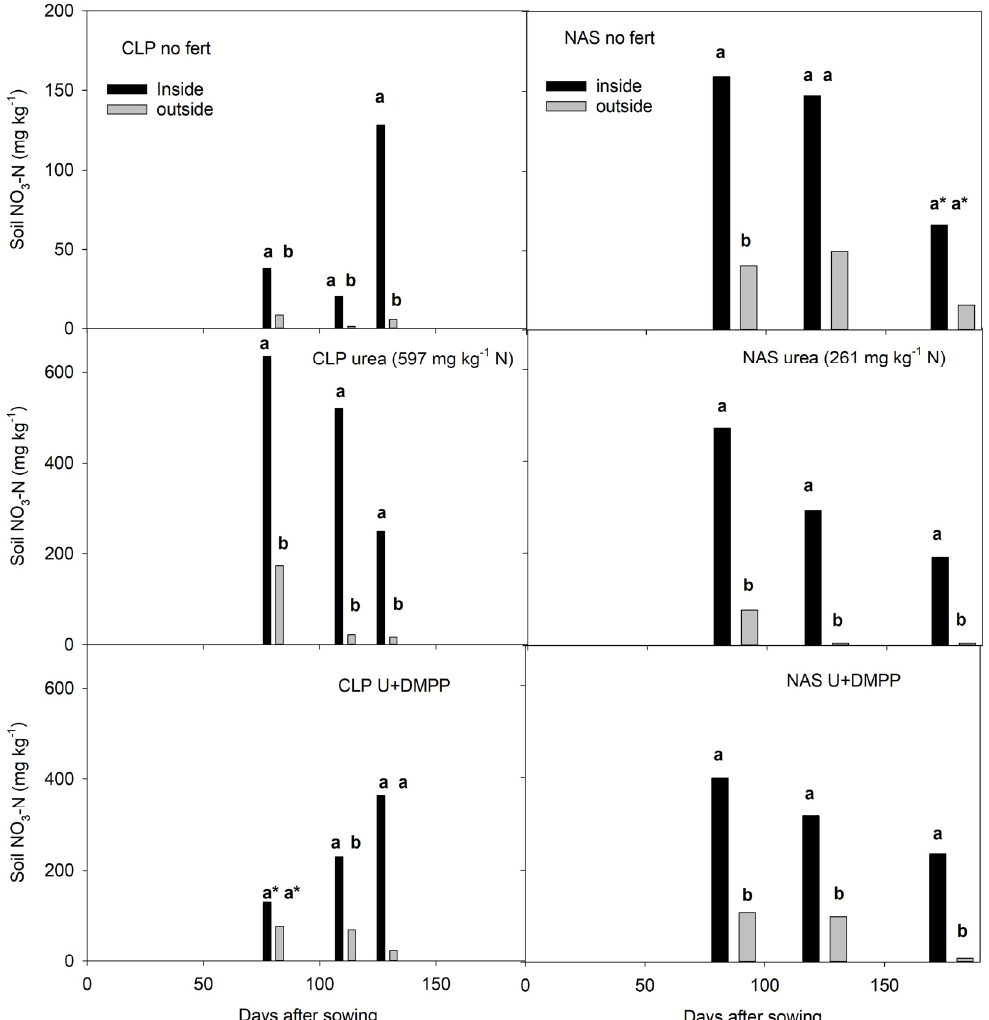
Figure 3. Soil 2M KCl-extractable NO 3 -N inside and outside root exclusion cylinders adjacent to the plant row of unfertilized, urea, and DMPP-coated urea soil at CLP and NAS sampled at key growth stages over the 2016/17 season. Results for soil NH 4 -N are not included as most were below the lowest level of reporting. Numbers in brackets indicate the N application rate per kg of soil. Bars within each sampling time (days after sowing) with the same letters are not significantly different ( p > 0.05). Asterisks indicates results for the pairwise comparison are not reliable (power of performed test <0.80).